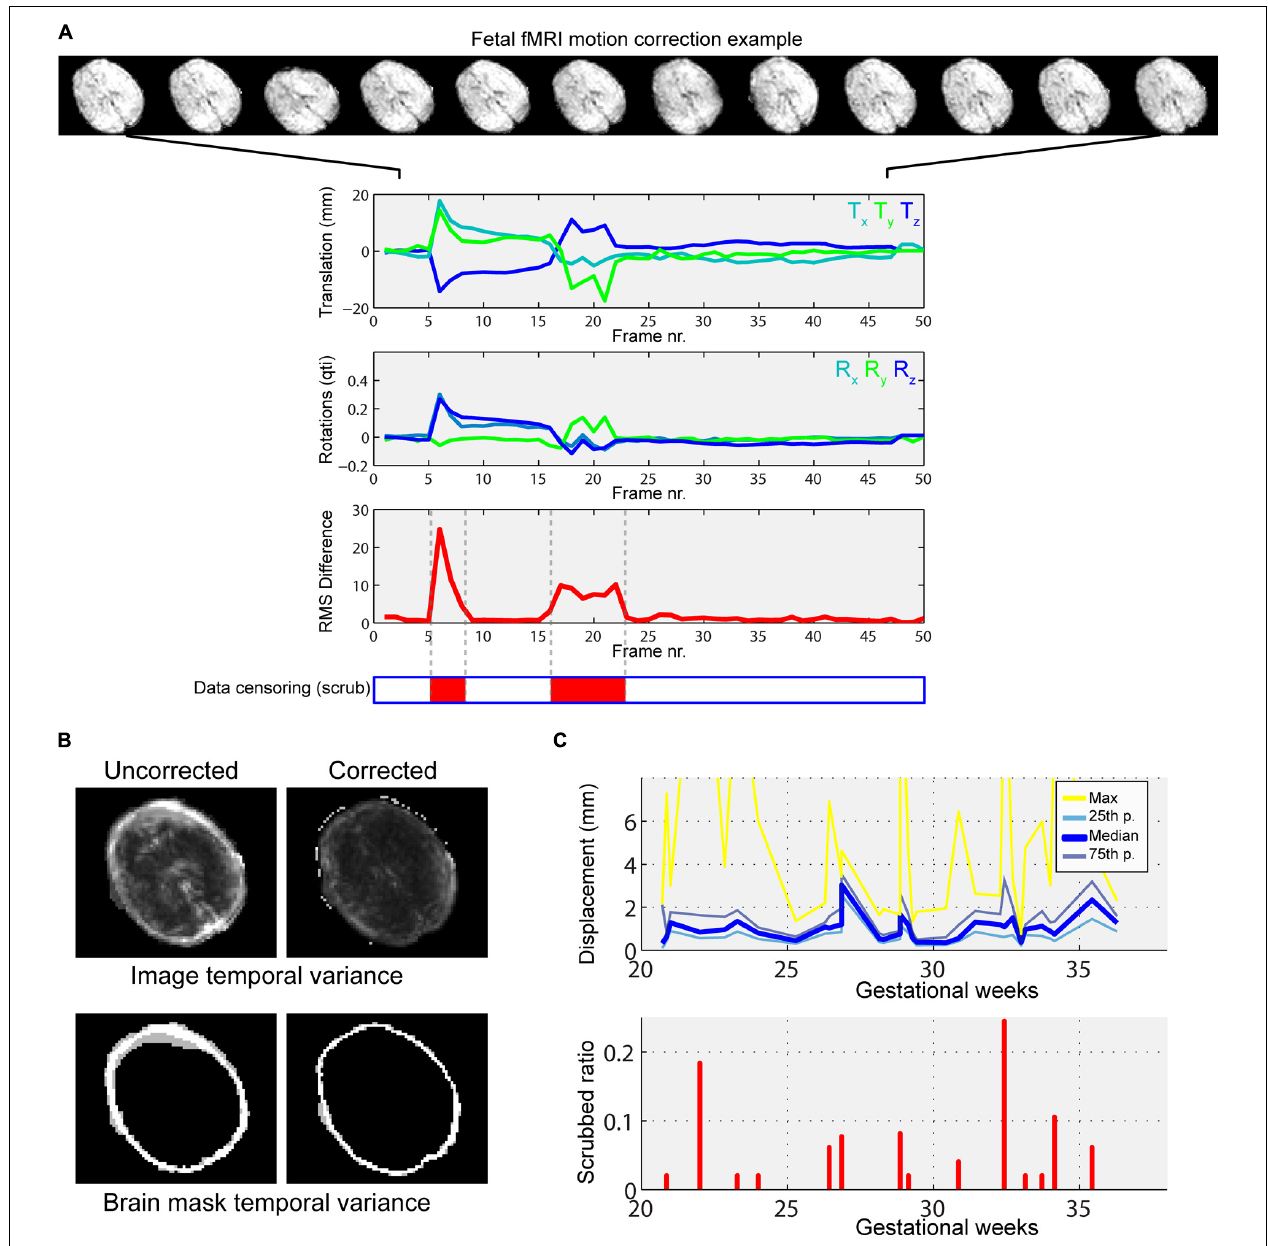
voxels, as shown in the cross-sectional panels. Such regions of high, spurious temporal variance give rise to nuisance signals in the functional connectivity patterns. (C) Depiction of gestational age-dependent changes of head motion. Top: median, 25th percentile, 75th percentile and maximum displacements of the fetal head vs. GWs. Bottom: the ratio of censored data vs. GWs. In our study cohort, fetal in-scanner head motion does not show correlation with gestational